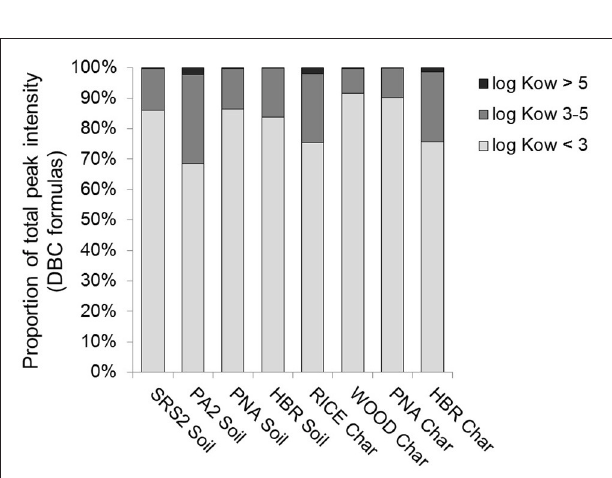
FIGURE 7 | Relative abundance of DBC formula-assigned peaks, as determined from FT-ICR/MS analysis, categorized according to log K ow , for soil and char